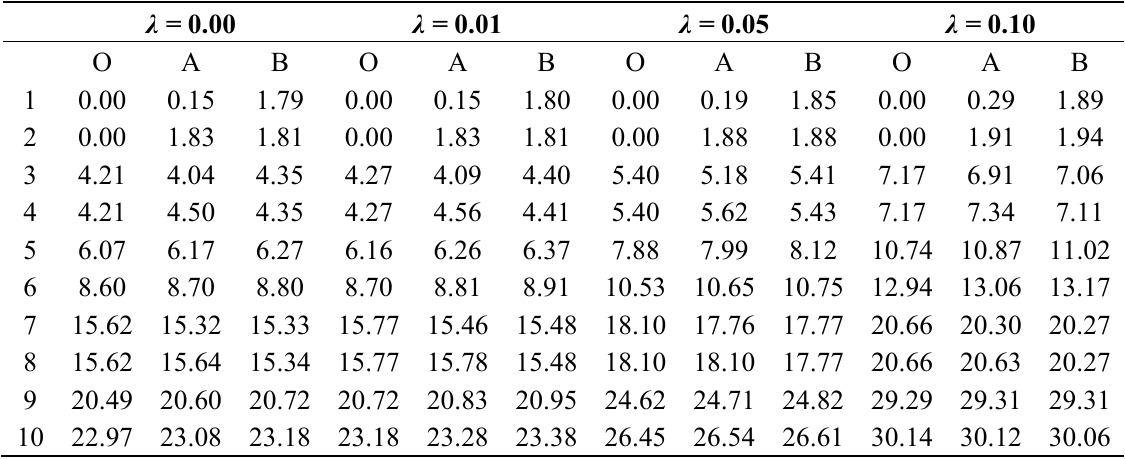
Table 2. Ten lowest frequency values